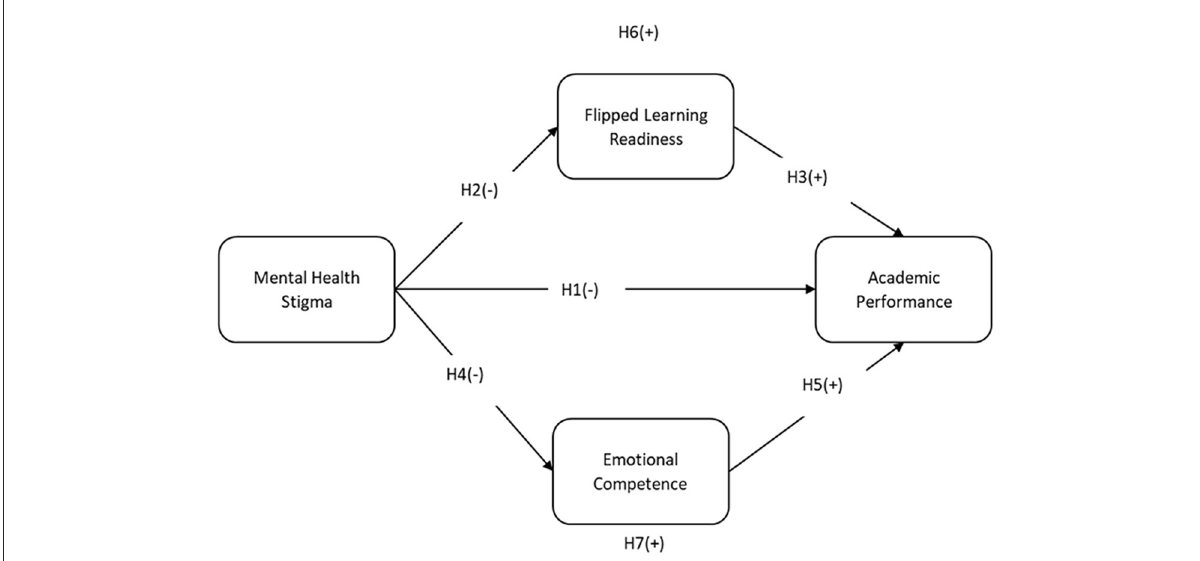
FIGURE1 Theoretical framework. ( + ) = positive relationship; (–) = negative relationship; H1, H2, H3, H4, H5 = direct relationships hypothesis; H6, H7 = mediating role relationships.